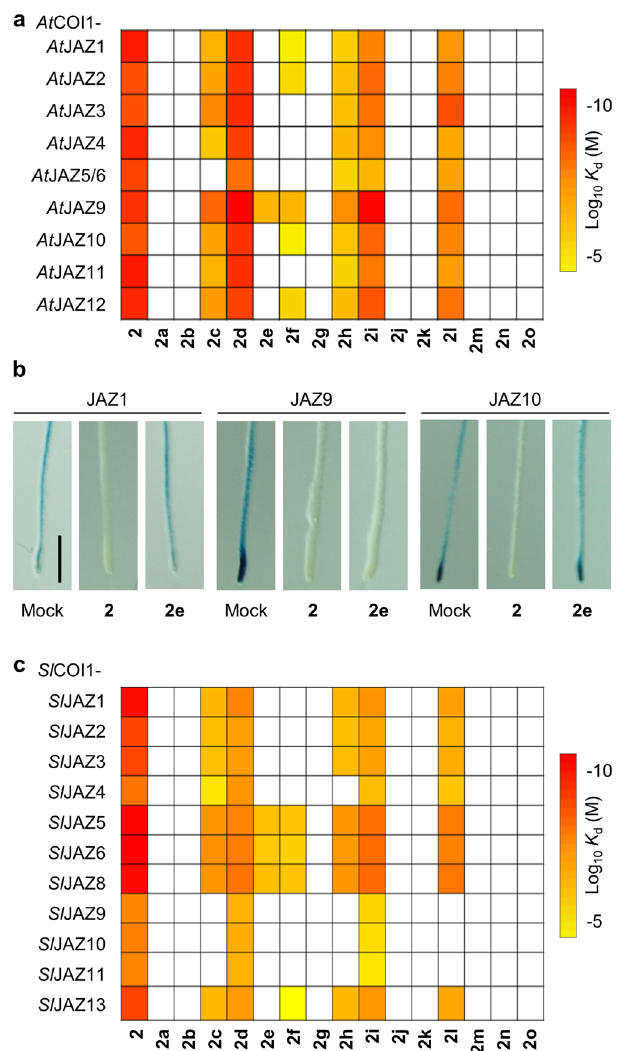
Fig. 2 Af fi nity heatmaps of coronatine stereoisomers on COI1-JAZ co- receptors of A. thaliana and S. lycopersicum . a Heatmap analyses of K d value of all stereoisomers for functional At COI1- At JAZ pairs. White means “ + not determined ” due to a low increase of FA (Supplementary Fig. 4). The color bar represents the K d value of each stereoisomer. K d value of each stereoisomer which increased FA value at 1 µ M was calculated by dose- response. b Evaluation of GUS activity in the roots of 4-day-old 35S: JAZ1- GUS , 35S-JAZ9-GUS , and 35S: JAZ10-GUS seedlings. Images of each seedling stained with 5-bromo-4-chloro-3-indolyl glucuronide were pretreated for 2 h with or without ligand (1 μ M). Similar results were obtained in three independent experiments. Scale bar, 1 mm. c Heatmap analyses of K d values of all stereoisomers for Sl COI1- Sl JAZ pairs. White means “ not determined ” due to a low increase of FA (Supplementary Fig. 10). The color bar represents the K d value of each stereoisomer. K d value of each stereoisomer which increased FA value at 1 µ M was calculated by dose-response